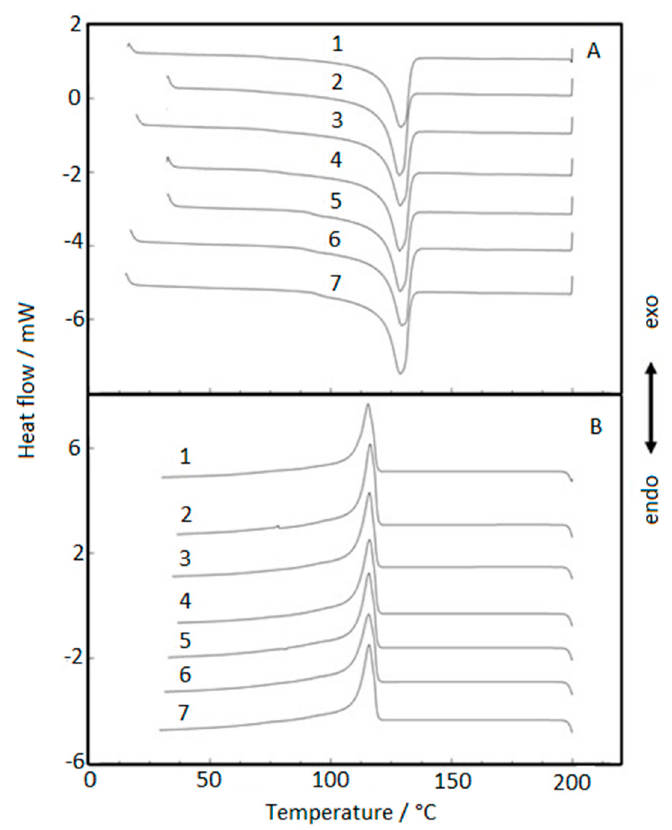
Figure 5. DSC curves: ( A ) melting point stage and ( B ) crystallization stage. 1—virgin sample; 2—960 h Xenon arc sample; 3—1639 h Xenon arc sample; 4—2160 h Xenon arc sample; 5—960 h UV fluorescent sample; 6—4380 h UV Fluorescent sample; and 7—8760 h UV fluorescent sample.